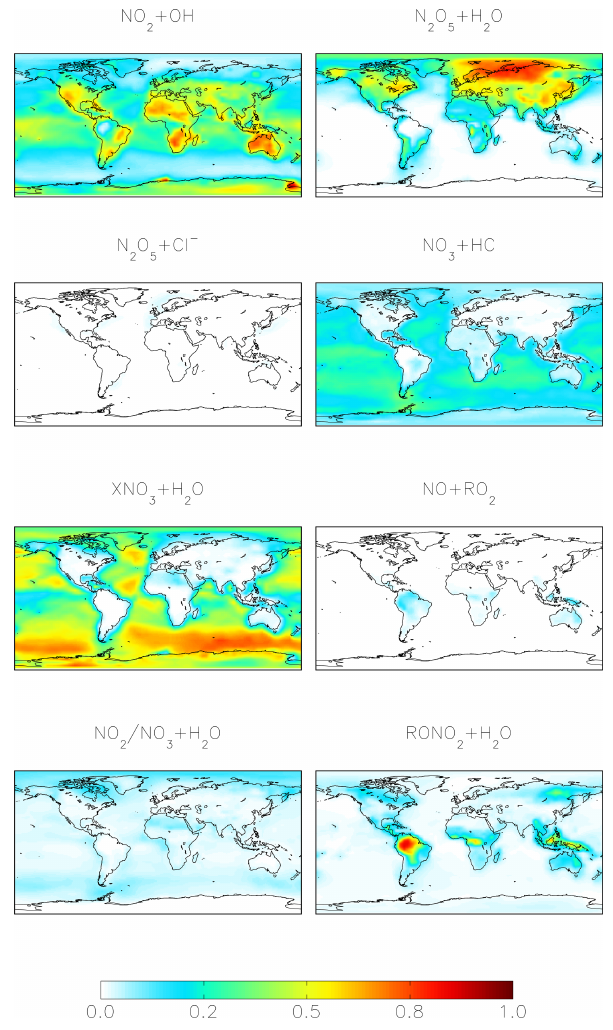
Figure 3. Annual-mean fraction of HNO 3 formation from the oxi- dation of NO x in the troposphere below 1km altitude in the cloud chemistry model.